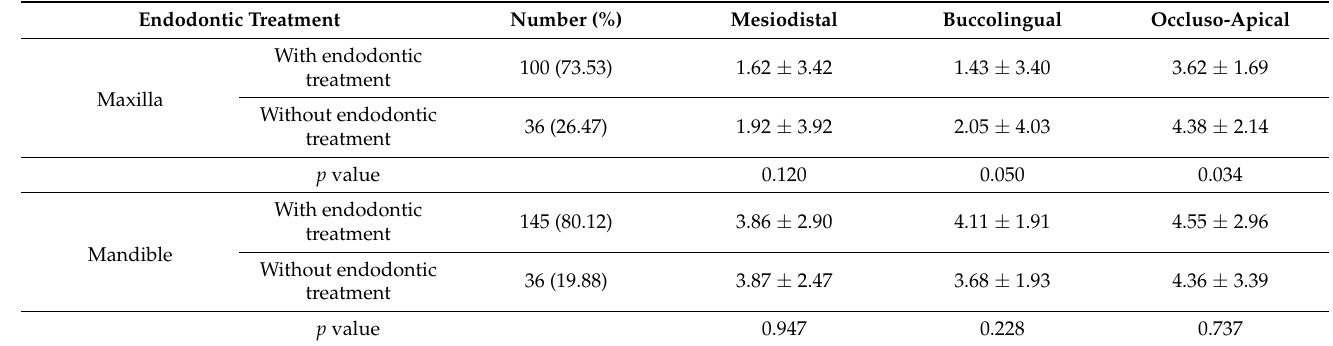
Table 3. Mean dimensions of endodontic lesions in the maxilla and mandible based on presence and absence of endodontic treatment.